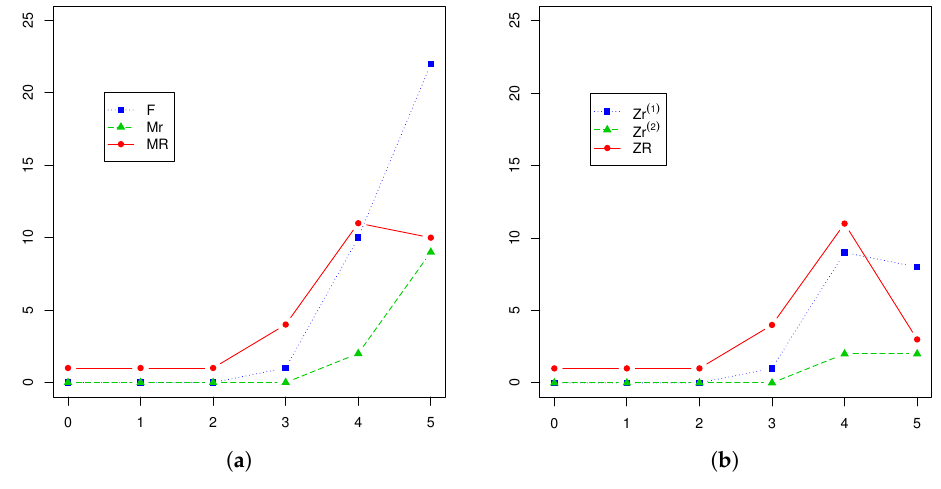
Figure 2. Evolution generation-by-generation of { ( F n , Mr n , MR n ) } 0 ≤ n ≤ 5 ( a ) and ( 2 ) { ( Zr ( 1 ) ) } n , Zr n , ZR n 0 ≤ n ≤ 5 ( b